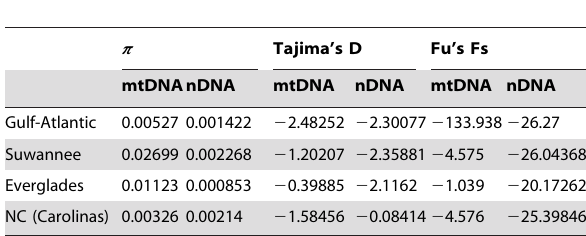
Table 5. Average pair wise genetic distances within and between green anole